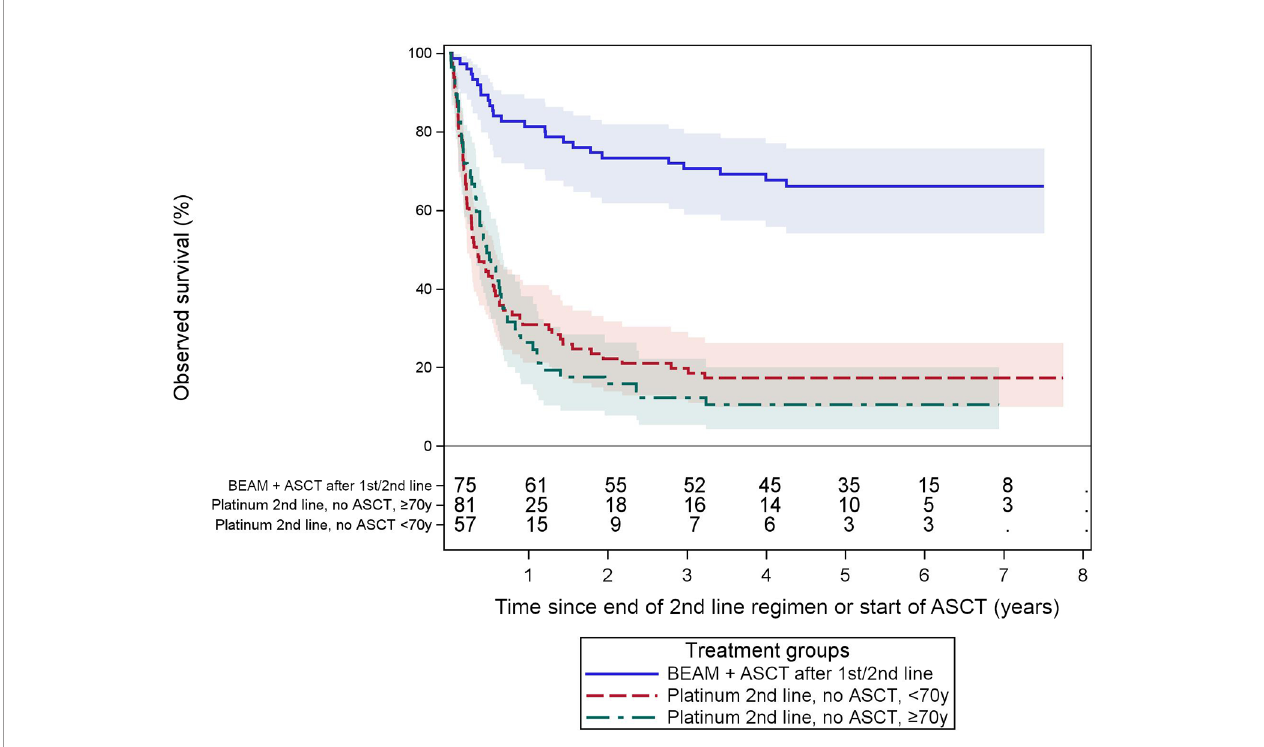
FIGURE 5 | Observed survival after ASCT or platinum-containing second-line treatment without ASCT. These Kaplan – Meier curves show the observed survival from the start of ASCT or end of second-line therapy in patients either receiving an ASCT after a BEAM-like conditioning or patients receiving platinum-based salvage regimens without ASCT. The latter strati fi ed by age (< or ≥ 70 years old). Observed survival in the groups without ASCT is poor compared to the ASCT group. The numbers of patients at risk are tabled below the curves. Colored areas represent the 95% con fi dence